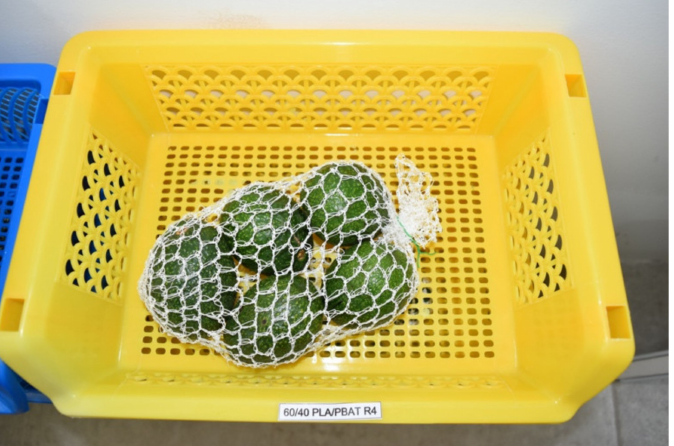
Figure 4. Avocado fruit bagged in net-based 60/40 PLA/PBA/pine essential oil at different concen- trations + 1% chitosan and stored at 25 ± 2 ◦ C for nine